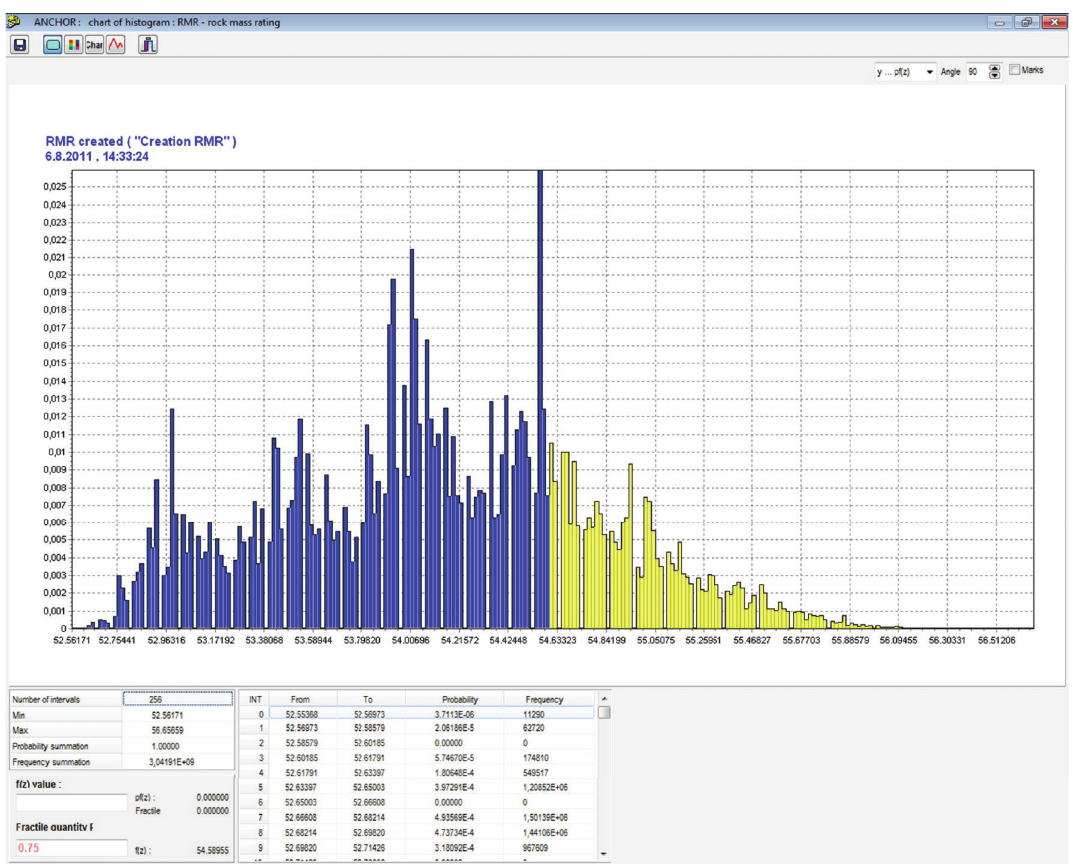
Figure 9: Software desktop with a table for determination of rock mass rating (the geomechanical classification coefficient RMR), [4].